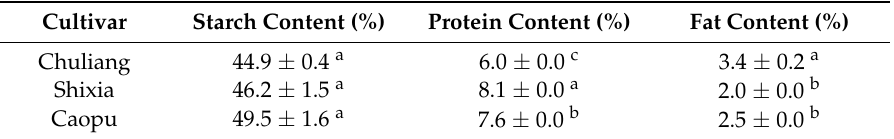
Table 1. Composition of longan seeds from various cultivars 1